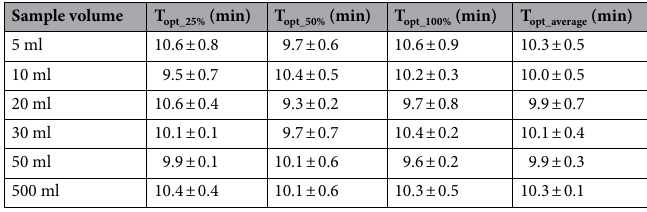
Table 3. T opt of samples with different volumes under various